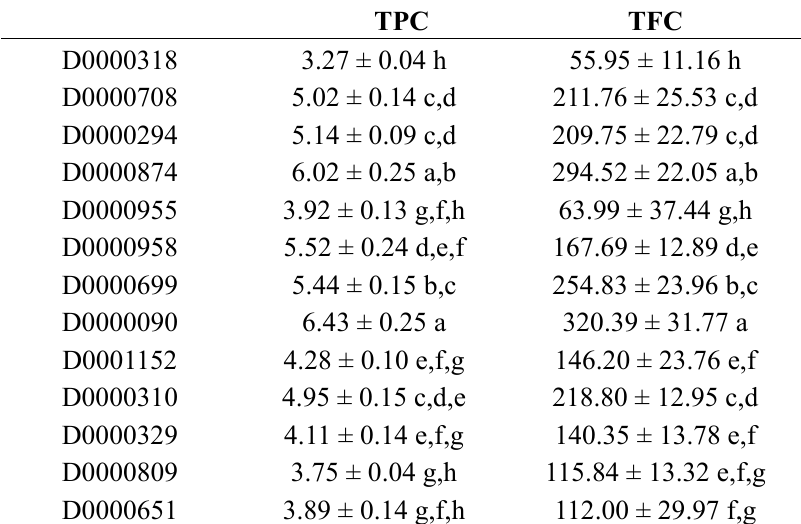
Table 2. Total phenolic contents (TPC) and total flavonoid content (TFC) of rice